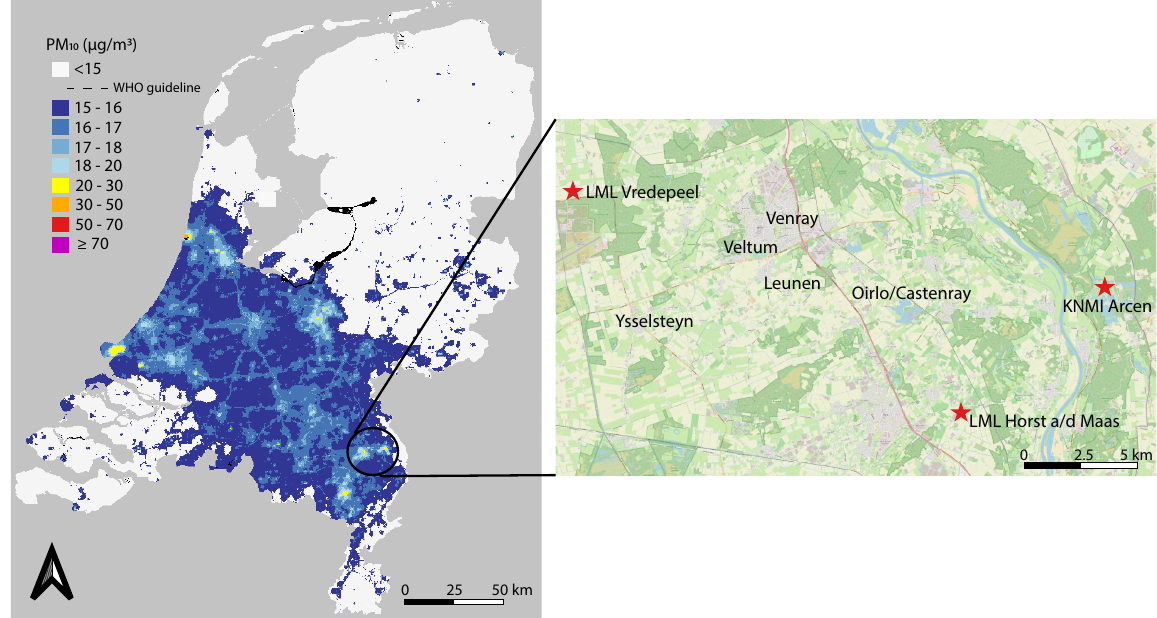
Figure 2. Map with average PM concentrations ( µ m/m 3 ) for the year 2019 and a map of Venray and its surroundings (area indicated on the PM map by the circle). The five areas where measurements were carried out are indicated on the map on the right, as well as the two official measurement stations and the KNMI weather station (red stars). ©OpenStreetMap contributors. Source of PM map: https://www.atlasleefomgeving.nl/kaarten (accessed on 16 March